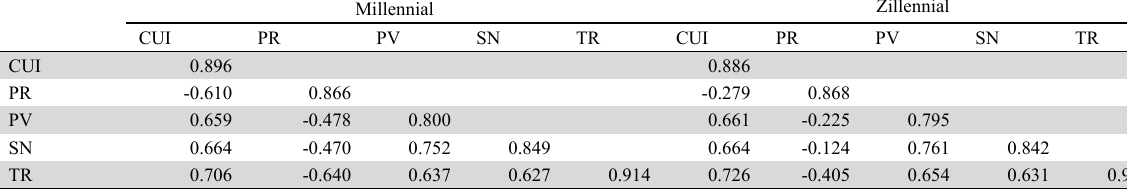
Discriminant Validity Test Using Fornell-Larcker Criterion Millennial Zillennial